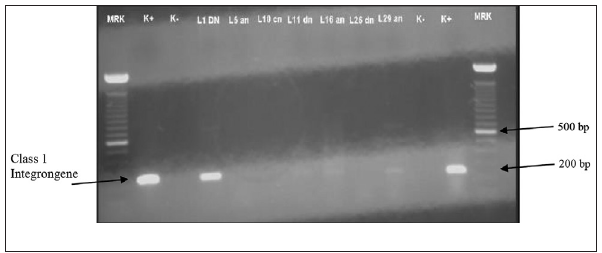
Figure-2: Class 1 integron gene identified from Citrobacter freundii using polymerase chain reaction from laying chickens in Blitar, Indonesia. MRK=Marker (100 bp); K+=Positive control; K-=Negative control;